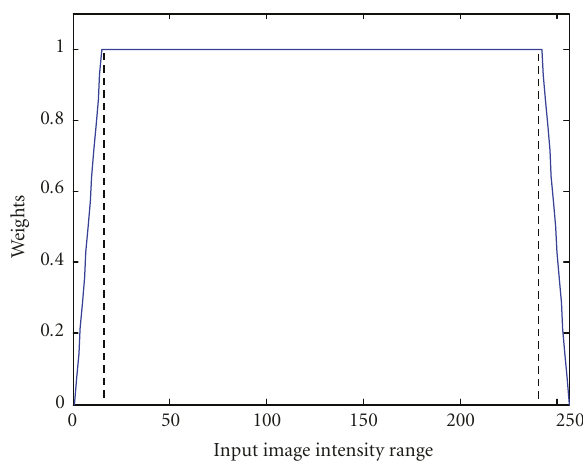
Figure 5: Piecewise linear certainty function used in the experi- ments. The intensity breakpoints in the figure are 15 and